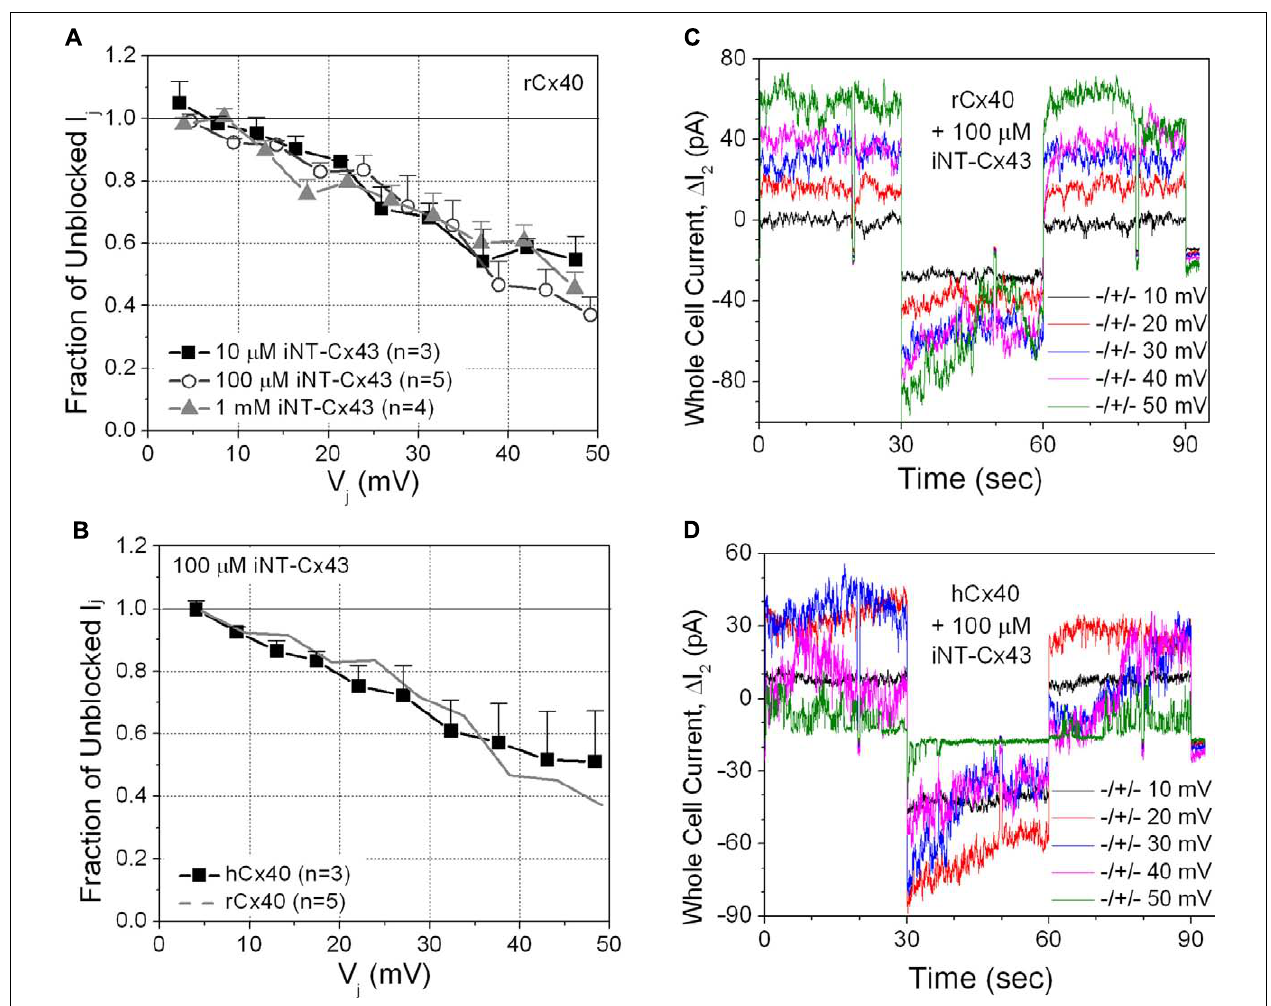
FIGURE 2 | (A) The inhibition of rCx40 gap junction currents ( I j ) by unilateral addition of 10 μ M ( (cid:2) ), 100 μ M ( (cid:5) ), or 1.0 mM ( (cid:6) ) iNT-Cx43 peptide increased in a transjunctional voltage ( V j )-dependent manner.There was no statistical difference between the three curves based on comparison of the means at each V j value. (B) The V j -dependent blockade of hCx40 gap junctions ( (cid:2) ) by 100 μ M iNT-Cx43 peptide was not significantly different from rCx40 (continuous gray line). (C) Whole cell current traces recorded from cell 2 of a rat Cx40 cell pair with 100 μ M iNT-Cx43 peptide added to cell 1 during